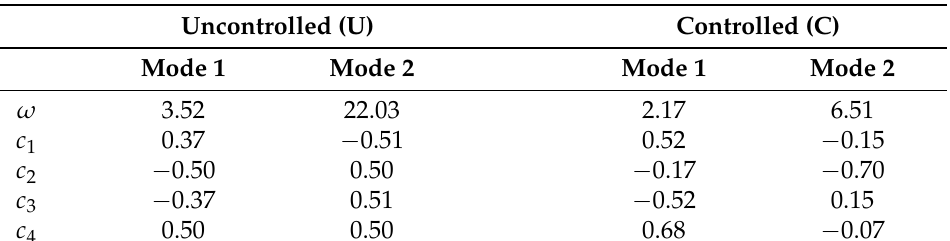
Table 1. Frequencies and coefficients of the natural modes 1 and 2 of both uncontrolled and controlled system; the modes are normalized according to ϕ ( 1 ) = 1. Internally resonant case for κ = 6.5.